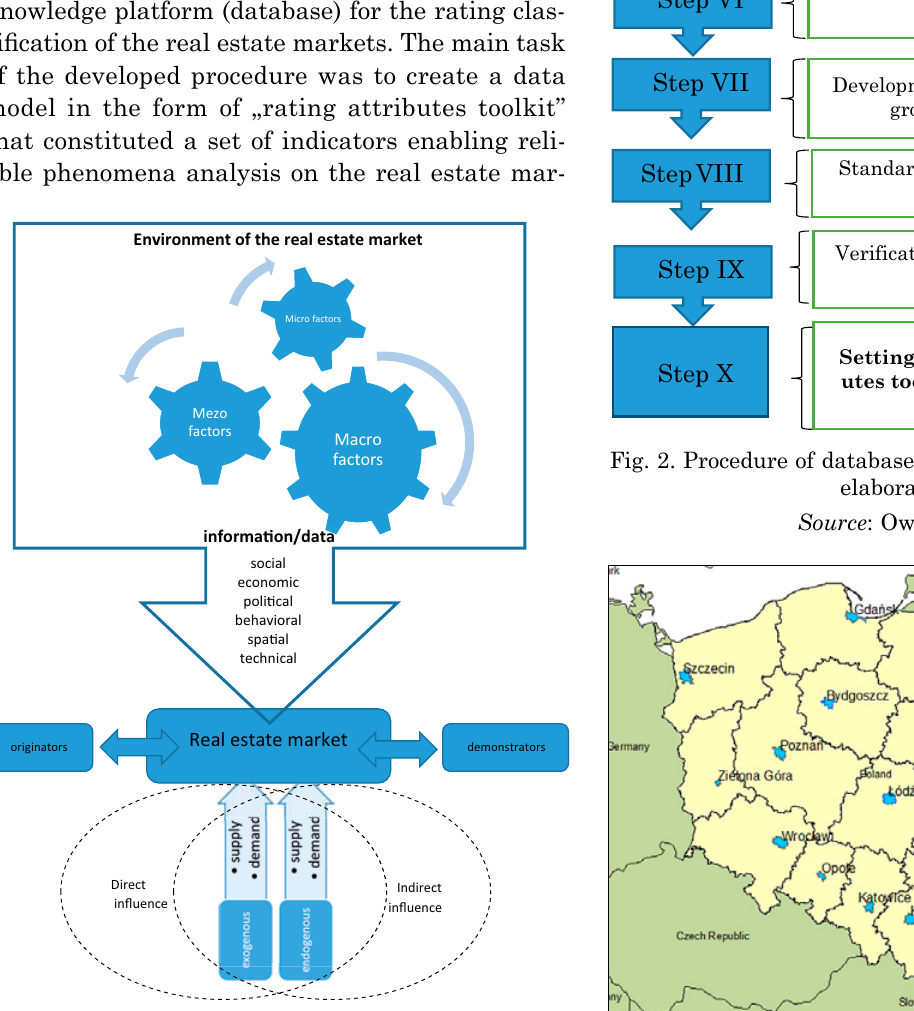
Fig. 1. Structure of the information system on the real estate market Source : own study.